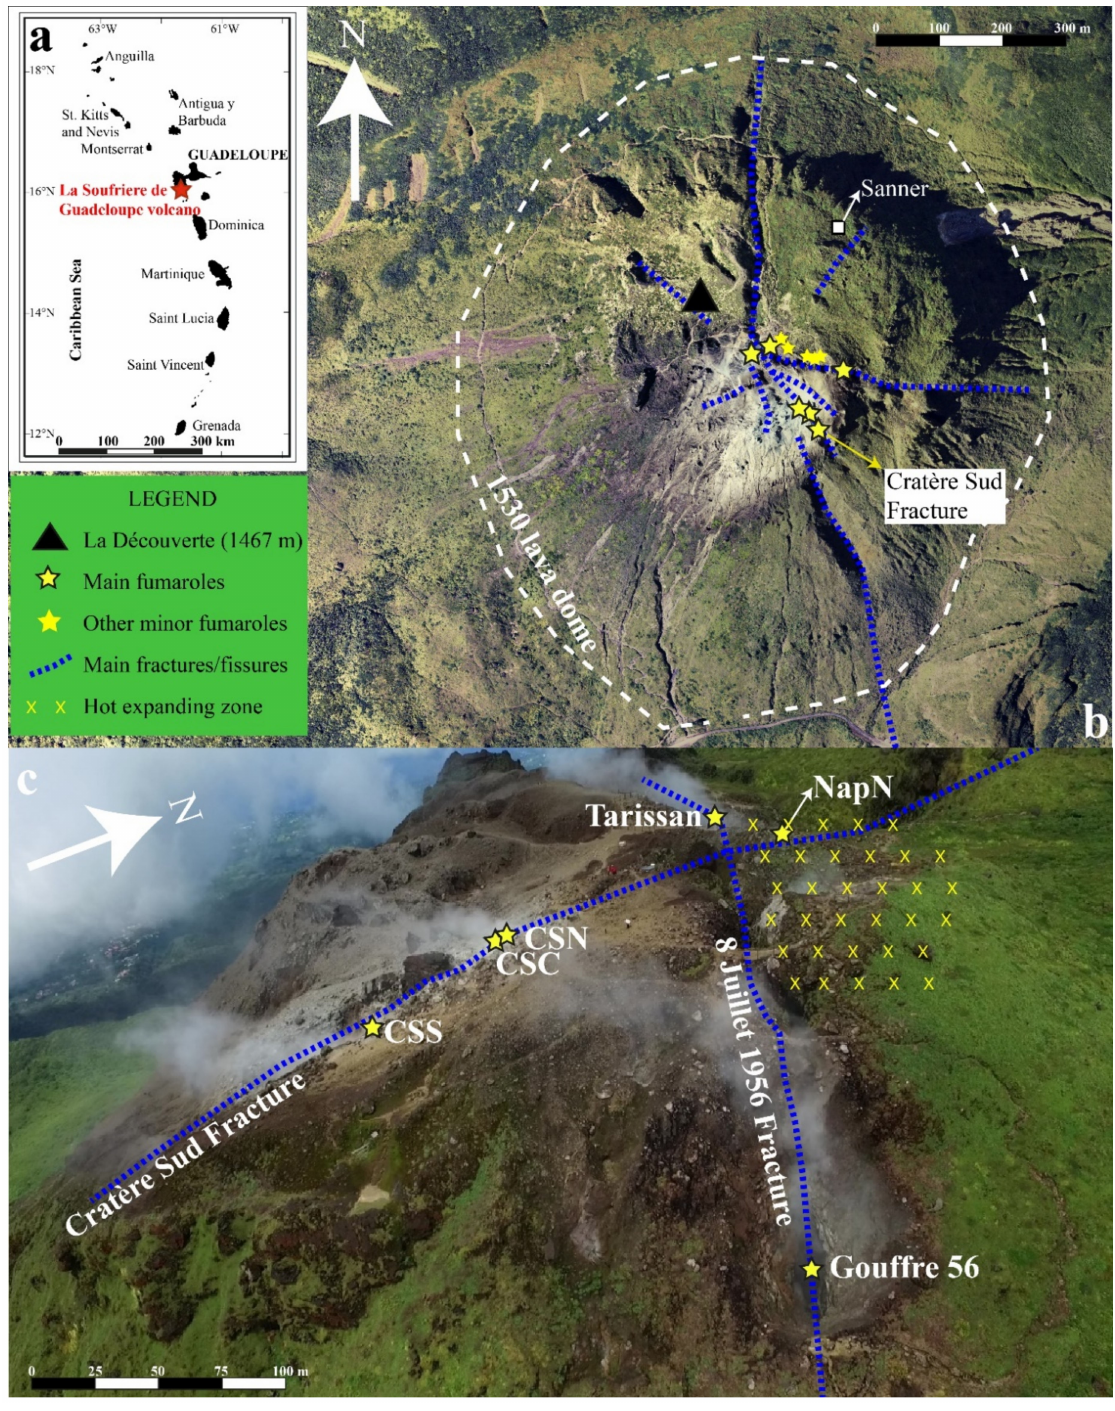
Figure 1. ( a ) Location map showing the position of Guadeloupe Islands regarding the Lesser Antilles volcanic arc. ( b ) Aerial photography of the 1530 dome (dashed white line) on the summit area of the La Soufriere de Guadeloupe volcano, including the distribution of fissures/fractures, main fumarolic emissions, and the position of the Sanner meteorological station. ( c ) Drone photography from the southeast portion of the dome showing the position of Crat è re Sud and 8 Julliet 1956 fractures, the location of main fumarolic emissions (Crat è re Sud Nord (CSN), Central (CSC), and Sud (CSS), plus Napoleon Nord (NapN) fumaroles), the Tarissan crater lake, and the Gouffre 56 pit, in addition to the ongoing hot expanding area (see text for further